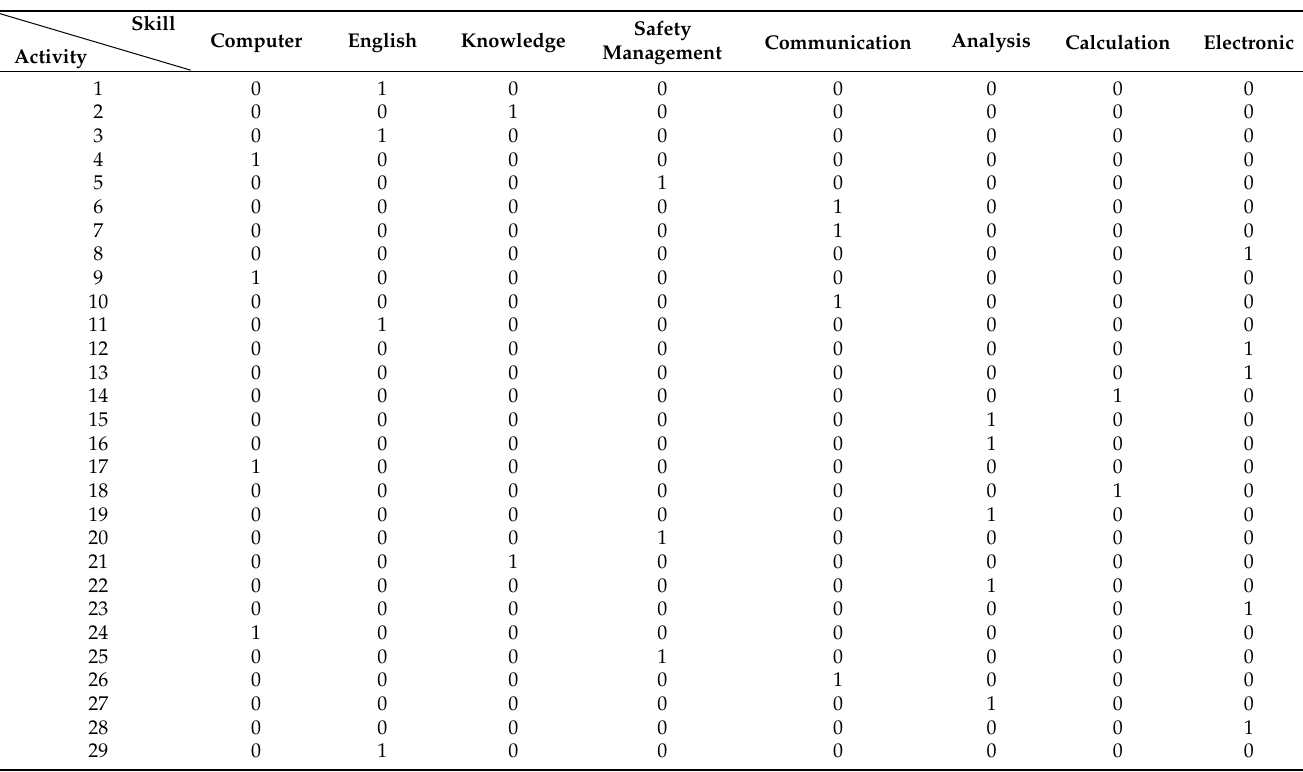
Table 5. Activity skill